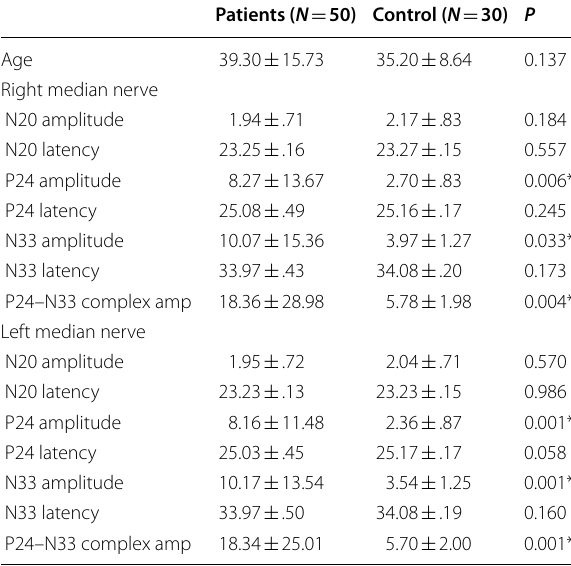
Table 2 SSEP in patients and control